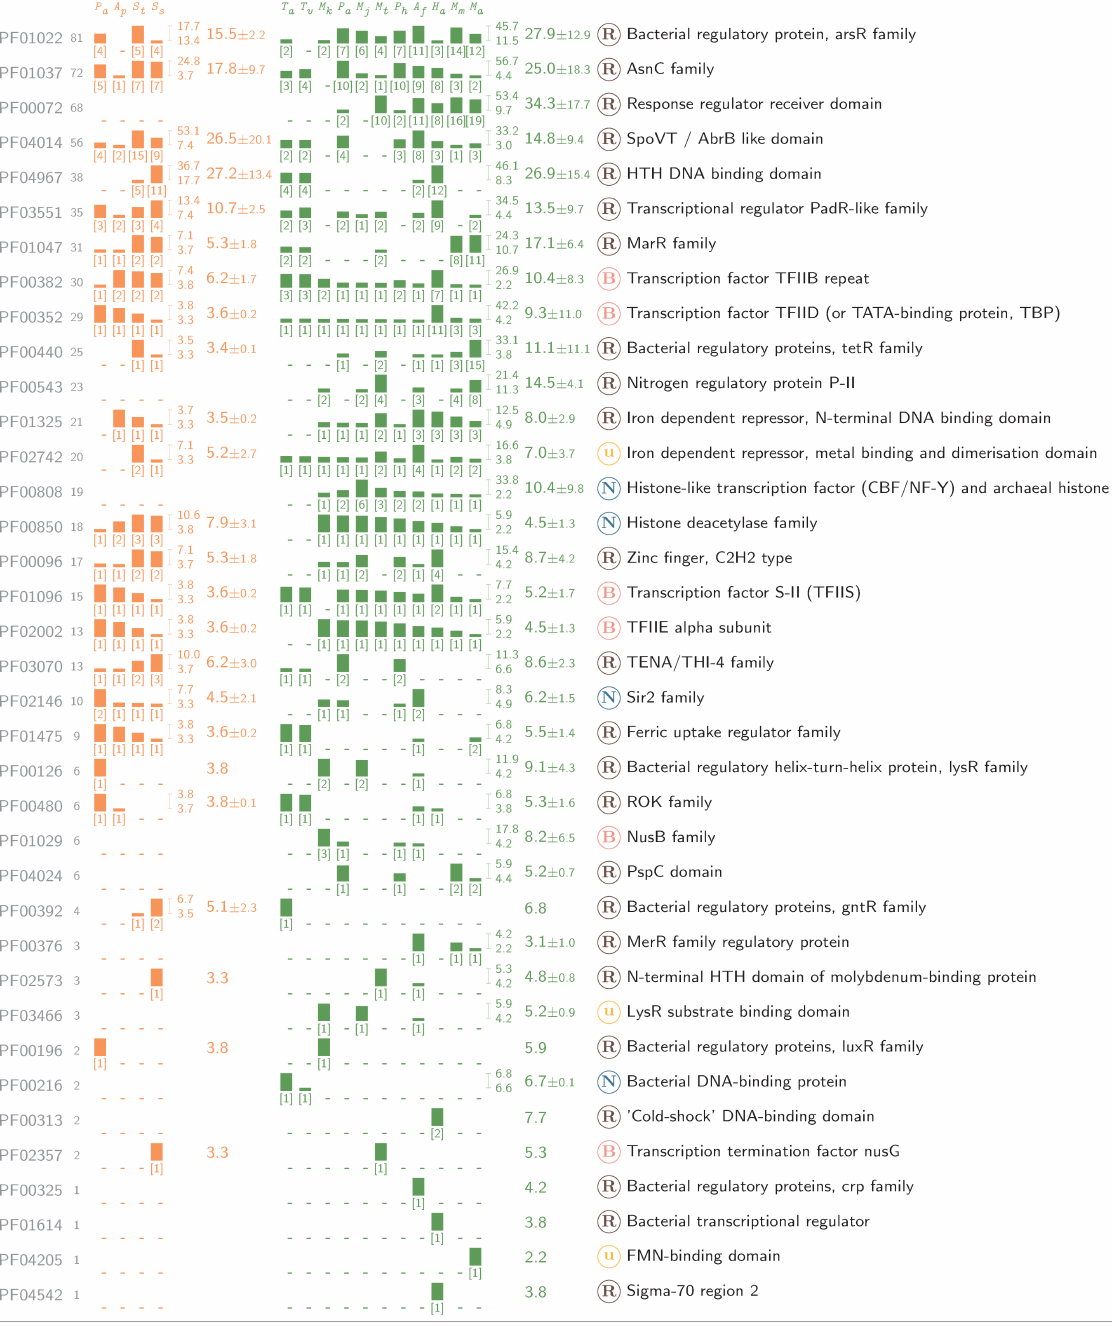
Figure 2. Phylogenetic distribution of genes matching protein domains associated with transcription. The Pfam accession numbers of the TA-HMMs that match archaeal sequences are shown on the left, with the next column indicating the total number of sequences matched in all the fifteen archaeal genomes. The matches in individual genomes are shown as bar graphs, and grouped into the two lineages (orange representing the Crenarchaeota, and green the Euryarchaeota), with the number of matching sequences normalised by genome size and expressed as number of se- quences per 10,000 genes. Beneath each bar graph, in square brackets, is shown the actual number of matchinggenes. The two numbers above one another and immediatelyto the right of the two groupings of bar graphs show the maximum and minimum number of matches for the phylum, and the column next to these values shows the mean number of matches with the standard deviation. The letter in the circle indicates which transcriptional functional class the TA-HMM is a member of: basal, elongation and termination factors (B); nucleosomes and HDACs (N); transcriptional regulators (R); unclassified (u). The Pfam description of the TA-HMM is shown at the right. Species codes: P. aerophilum ( P a ); A. pernix ( A p ); S. tokodaii ( S t ); S. solfataricus ( S s ); T. acidophilum ( T a ); T. volcanium ( T v ); M. kandleri ( M k ); P. abyssi ( P a ); M. jannaschii ( M j ); M. thermoautotrophicum ( M t ); P. horikoshii ( P h ); A. fulgidus ( A f ); Halobacterium sp. ( H a ); M. mazei ( M m ); and M. acetivorans ( M a